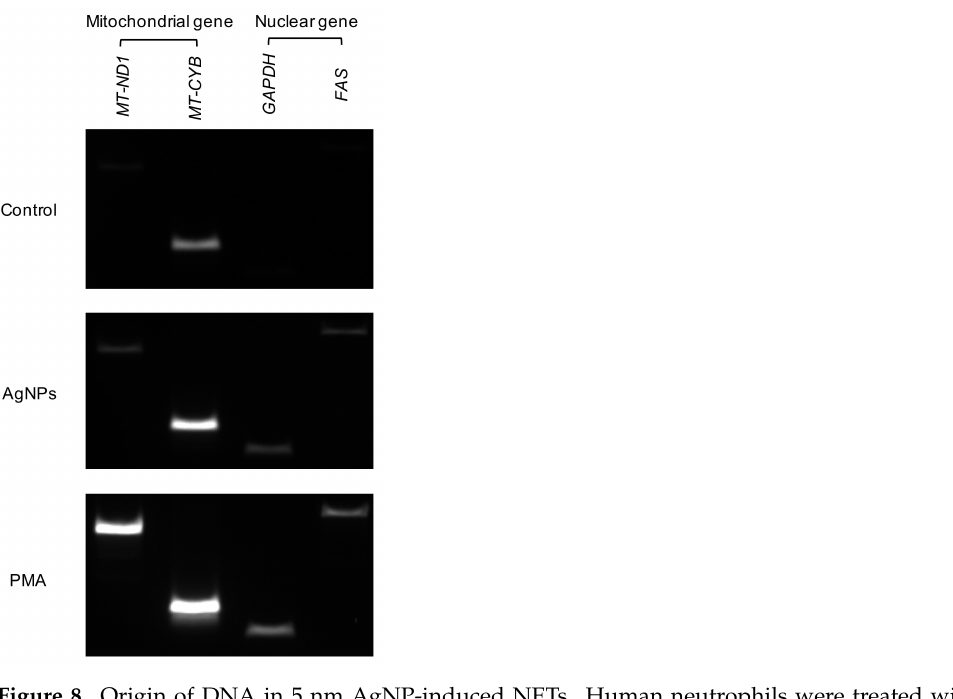
Figure 8. Origin of DNA in 5 nm AgNP-induced NETs. Human neutrophils were treated with 1.6 µ g/mL 5 nm AgNPs or 5 ng/mL PMA for 4 h, and DNA were isolated from the supernatant. Mitochondrial genes ( MT-ND1 and MT-CYB ) and nuclear genes ( GAPDH and FAS ) were amplified from isolated DNA. This experiment was performed in duplicate and repeated three times with different